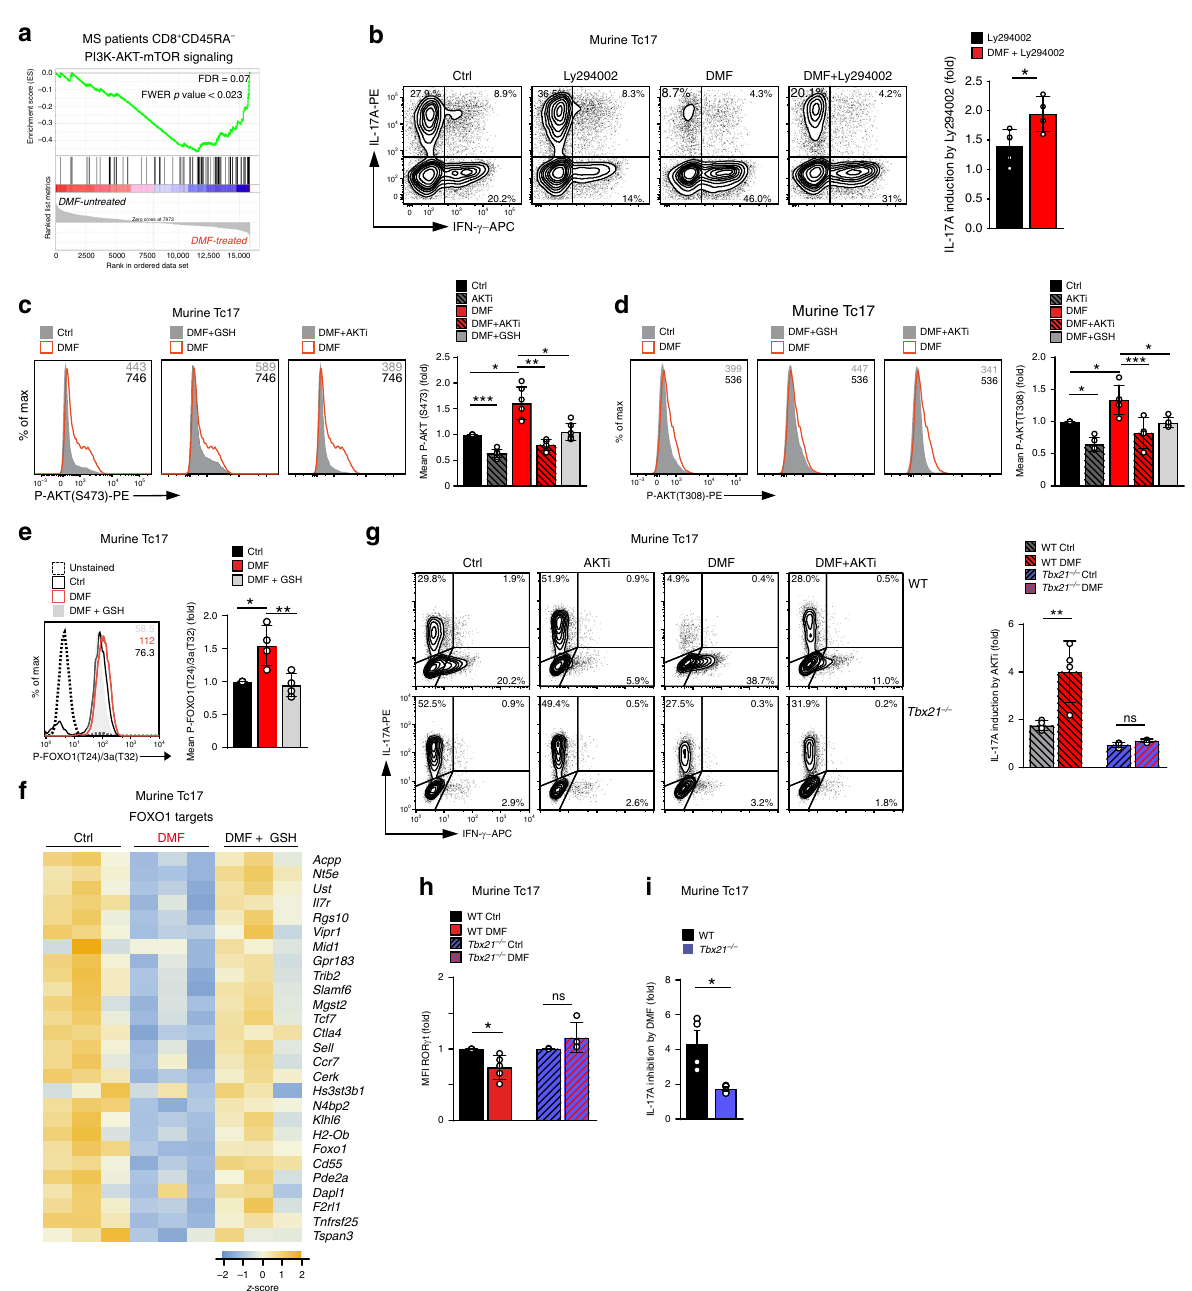
Fig. 3 DMF enhances PI3K-AKT-T-BET-signaling to diminish IL-17 and ROR γ t in Tc17 cells. a GSEA examining the enrichment of genes associated with PI3K-AKT-mTOR-signaling in human CD8 + CD45RA − T cells upon stable response to DMF therapy based on MSigDBv6.1 (dataset from Fig. 2f). b Flow cytometry of IL-17A in murine Tc17 cells differentiated for 72h ±DMF,±1 µ M Ly294002 (fold IL-17A induction by Ly294002, a PI3K inhibitor). c , d Flow cytometry of P-AKT(S473) c and P-AKT(T308) d in murine Tc17 cells differentiated for 48h±DMF, DMF + GSH,±1 µ M AKTi (AKT-1/2 inhibitor) or DMF + AKTi. e Flow cytometry of P-FOXO1(T24)/FOXO3a(T32) in Tc17 cells differentiated for 48h±DMF or DMF + GSH. Bars to the right in c , d , and e show fold MFI normalized to the respective control, which was arbitrarily set to 1. f Heatmap of color-coded z-scores from the rlog transformed, batch-corrected FOXO1 target genes according to Michelini et al 44 in Tc17 cells, (dataset from Fig. 2a). g Flow cytometry for IL-17A and IFN- γ in WT and Tbx21 − / − Tc17 cells differentiated for 72h with indicated treatment (fold IL-17A induction by AKTi). h Flow cytometry for ROR γ t in WT and Tbx21 − / − Tc17 cells differentiated for 72h with indicated treatment. Bars show fold ROR γ t expression (MFI normalized to respective control, which was arbitrarily set to 1). i Flow cytometry for IL-17A in WT and Tbx21 − / − Tc17 cells differentiated for 72h (fold IL-17A inhibition by DMF). Bars show mean±s.d. from six c , fi ve to four b , d , e and g – i combined experiments; individual values are plotted. In b , g , i * p <0.05, ** p <0.01 evaluated by two-tailed, unpaired t -test, in h * p <0.05 by two-tailed un p aired t -test with Welch ’ s correction, in (d and e) * p <0.05, ** p < 0.01, *** p <0.001 by one-way ANOVA followed by Tukey ’ s HSD multi p le comparison test, in c * p <0.05, ** p <0.01, *** p <0.001 by one-way Welch ’ s ANOVA with Games-Howell multiple comparison